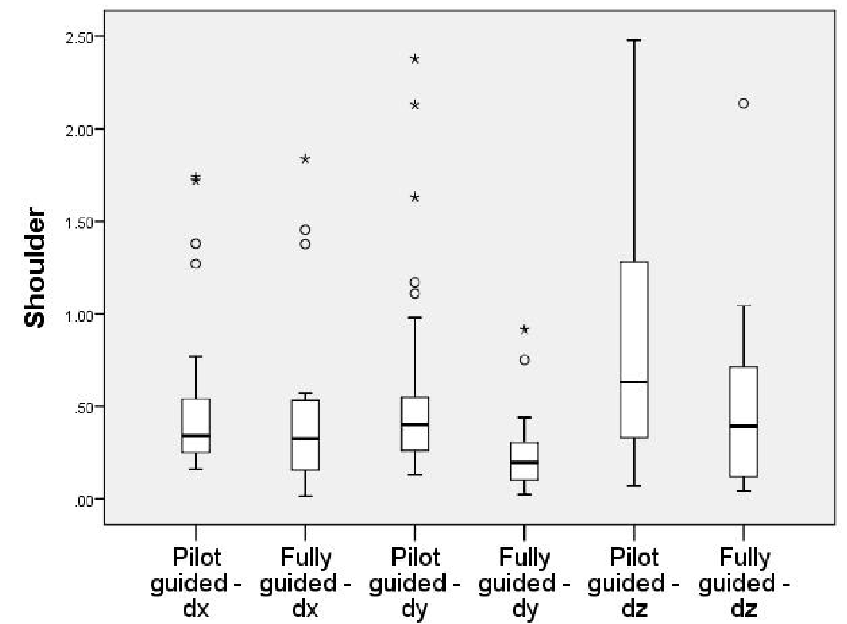
Figure 7. Box plots for deviations—shoulder area. (Circle and asterisk representing outlier(values that do not fall in the whisker bars) and extreme outlier(values more than three times the height of the boxes), respectively.). Appl. Sci. 2020 , 10 , x FOR PEER REVIEW